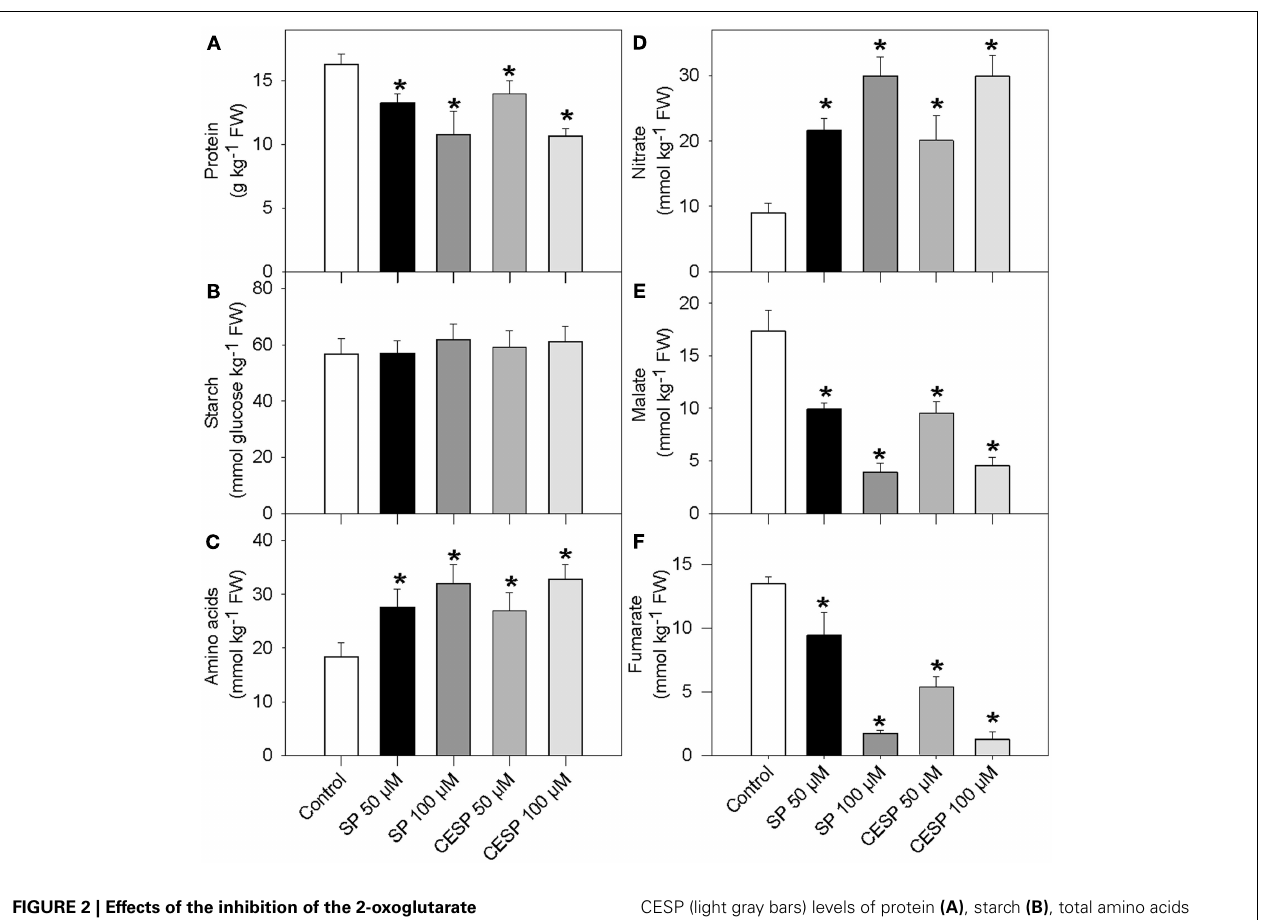
FIGURE 2 | Effects of the inhibition of the 2-oxoglutarate dehydrogenase complex activity on metabolite levels. Following 4h incubation of Arabidopsis leaf disks in exactly similar light growth conditions in the absence (white bars) or presence of 50 μ M SP (dark bars), 100 μ M SP (dark gray bars), 50 μ M CESP (gray bars), or 100 μ M